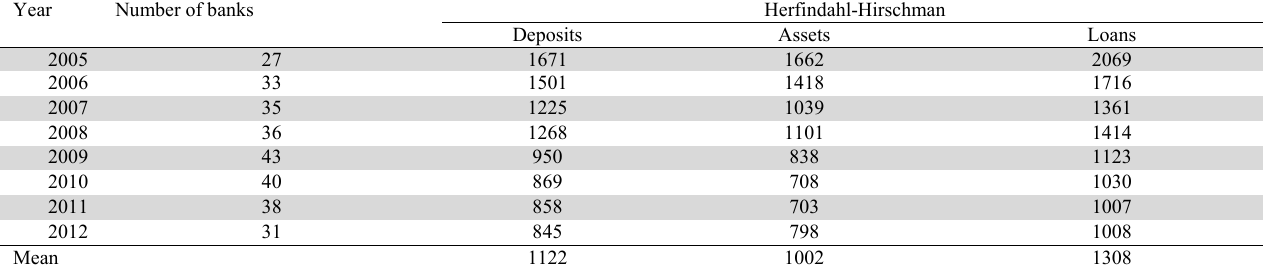
Herfindahl-Hirschman of Vietnamese banking sector,